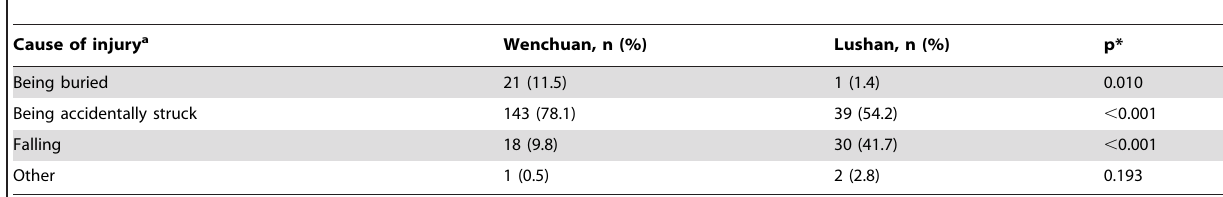
Table 1. Comparison of the causes of chest injury in patients admitted to our hospital in the Wenchuan and Lushan earthquakes.